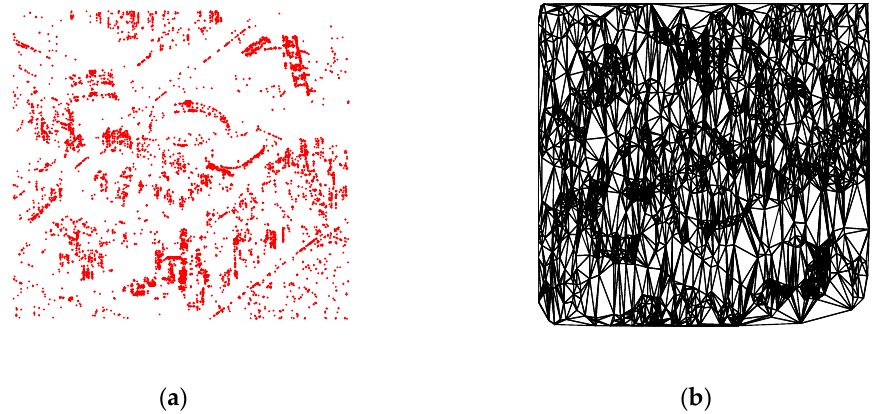
Figure 6. SPSCs and the first-tier network ( a ) SPSCs marked with red solid points; ( b ) first-tier network